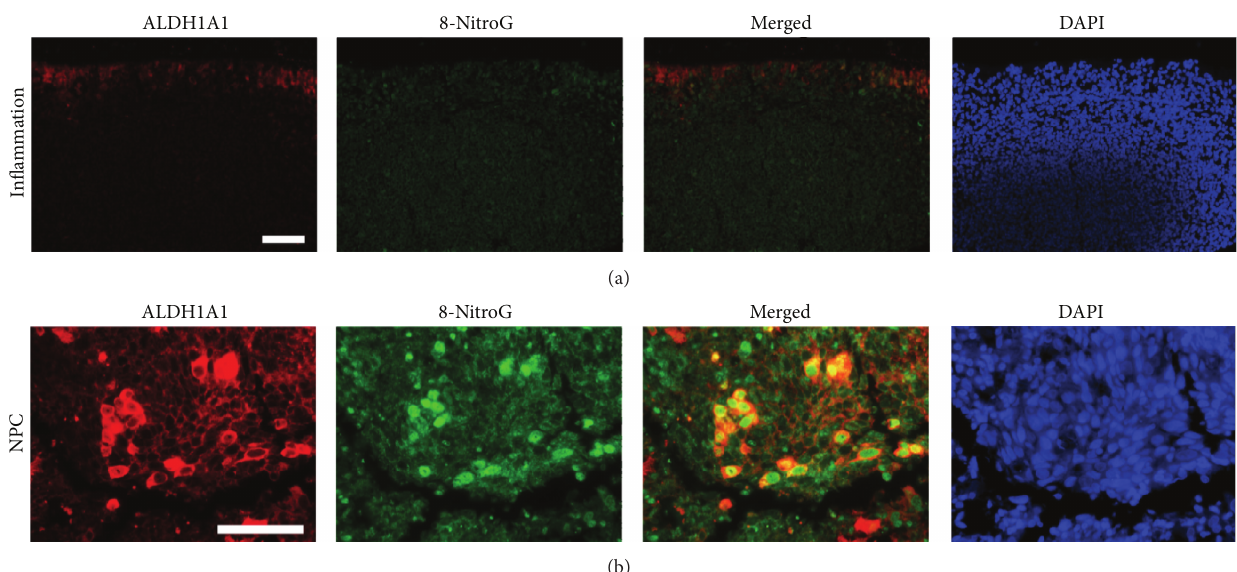
Figure2:DoubleimmunofluorescencestainingofALDH1A1and8-nitroguanineinchronicnasopharyngitisandNPCtissues.Theexpression of 8-nitroguanine (green) and ALDH1A1 (red) was assessed by immunofluorescence staining. Nuclei were counterstained by DAPI (blue). Original magnification is 100x (a) and 200x (b). Scale bar represents 50 𝜇